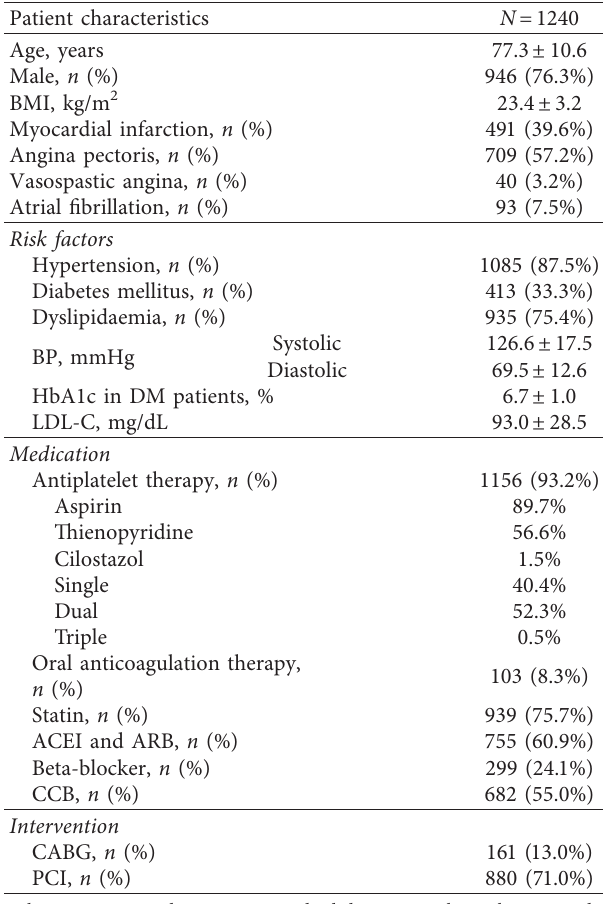
Table 1: Baseline characteristics of the patients with ischaemic heart